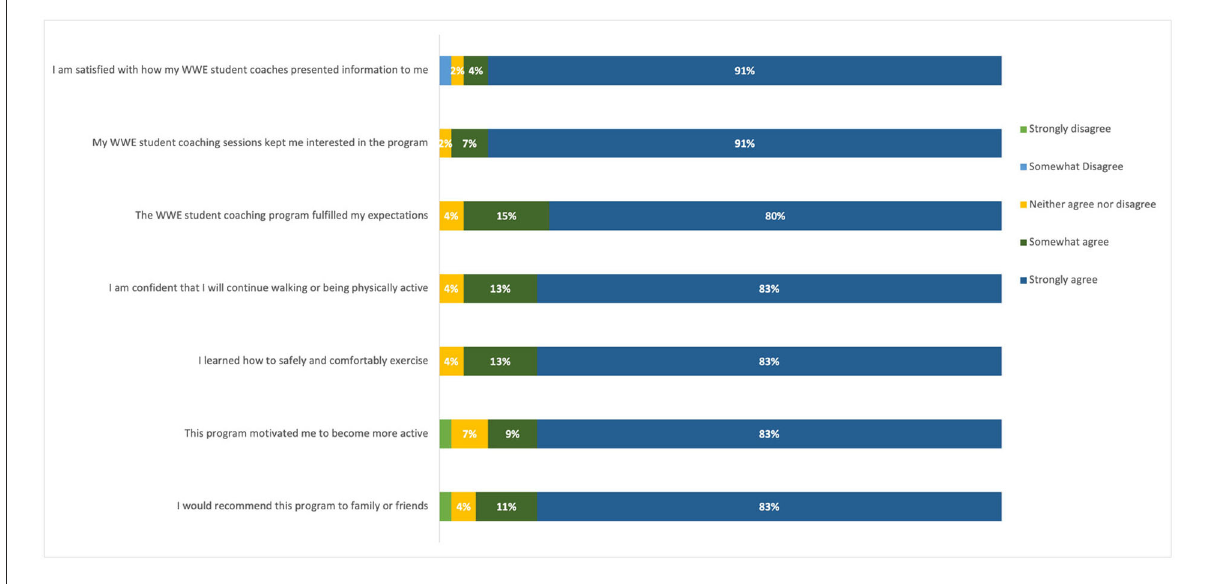
FIGURE1 Participant survey results ( N =